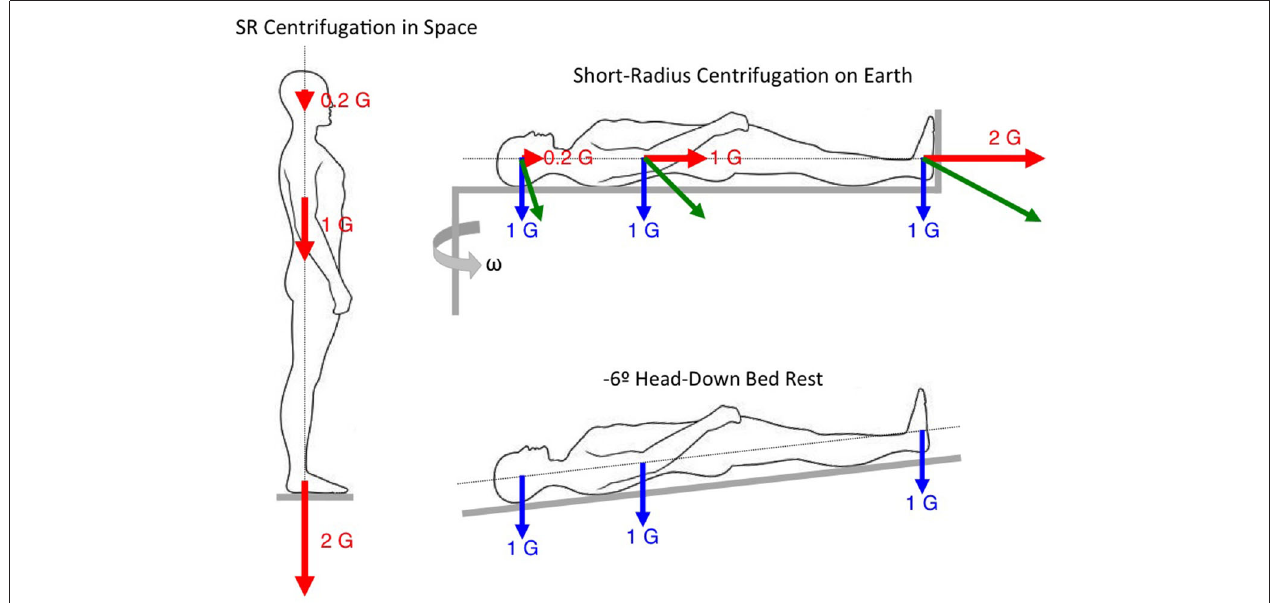
FIGURE 4 | Rationale for evaluating the effects of intermittent short-radius centrifugation during bed rest